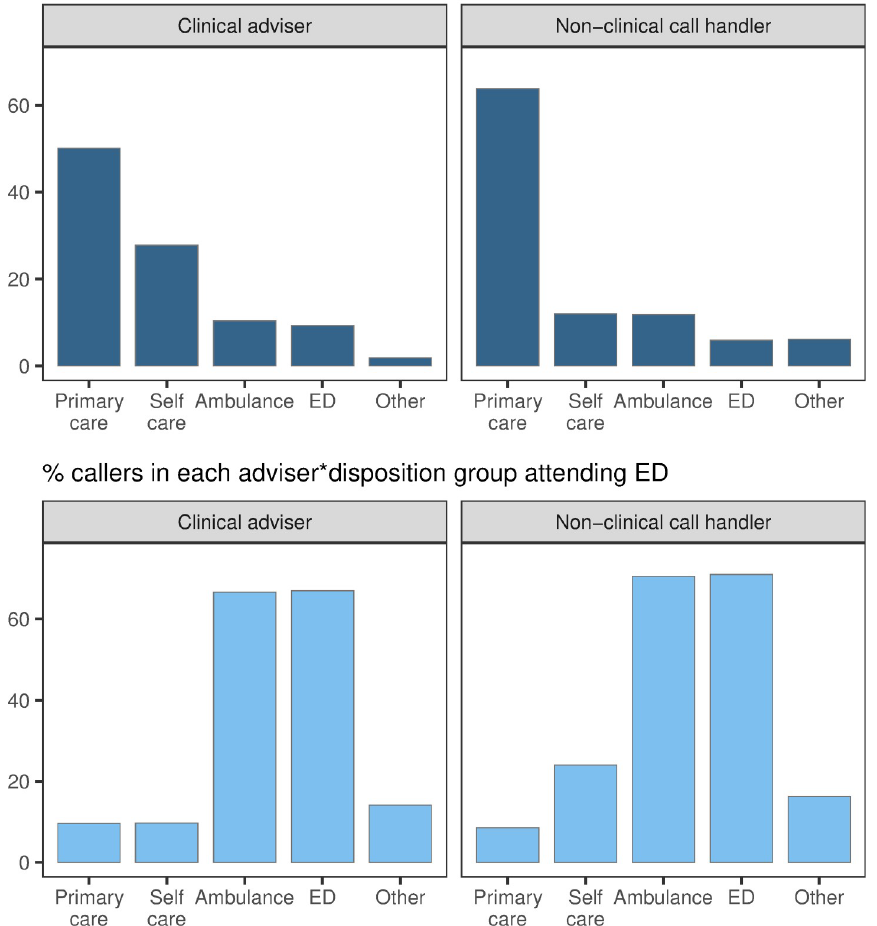
Fig 5. Proportion of callers given each disposition and attending ED, split by call handler. Top: percent of NHS 111 callers advised by each adviser type receiving each disposition; e.g., 50.1% of those advised by a clinical adviser received a primary care disposition. Bottom: percent of NHS 111 callers in each adviser-disposition group who attended ED; e.g. 9.6% of those advised by a clinical adviser who received a primary care disposition attended